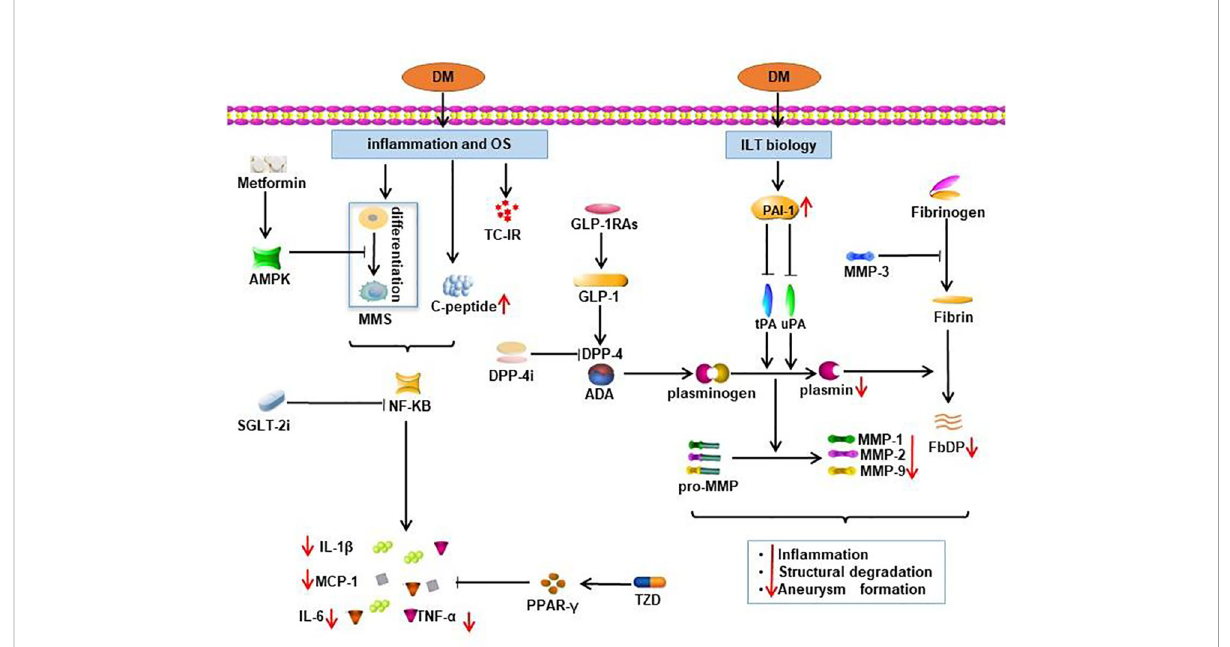
FIGURE 2 Potential mechanisms of the protective effect of oral antidiabetics on AAA. Effects of oral antidiabetics are demonstrated by red arrows. TC-IR, T-cell insulin receptors; DM, diabetes mellitus; MMS, monocyte-macrophage system; OS, oxidative stress; FbDP, Fibrin degradation products; DPP-4i, dipeptidyl peptidase 4 inhibitors; SGLT-2i, sodium-glucose cotransporter 2 inhibitors; GLP-1RAs, glucagon-like peptide 1 receptor